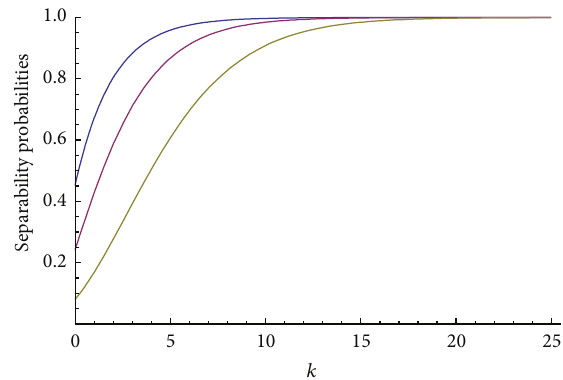
Figure 1: Two-rebit > two-qubit > two-quaterbit separability prob- abilities, given by (5), (3), and (4), respectively, as functions of 𝑘 = 𝐾 − 4.